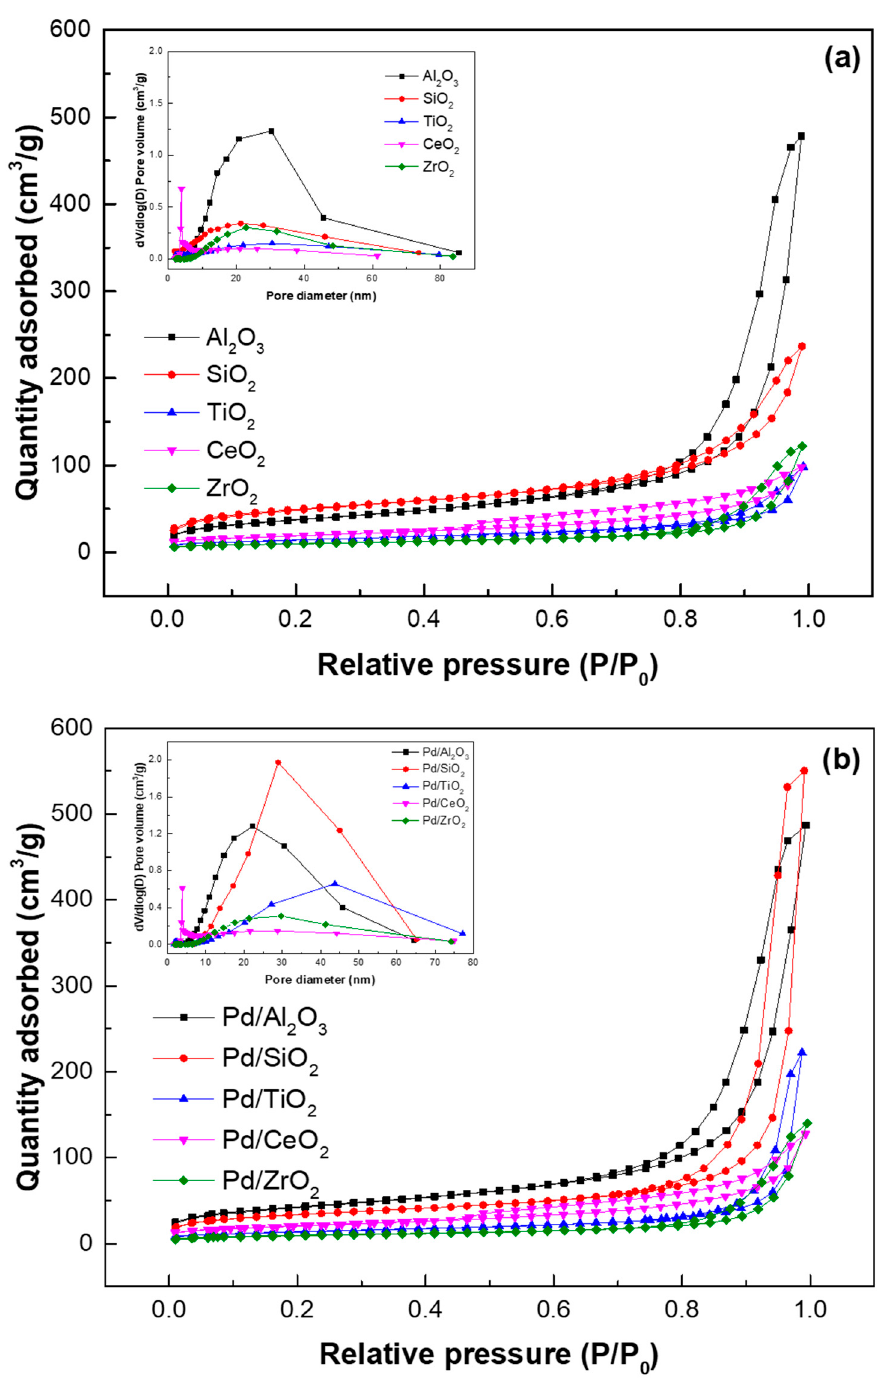
Figure 2. N 2 adsorption-desorption isotherms and pore size distributions (insets) of ( a ) supports and ( b ) supported Pd catalysts.